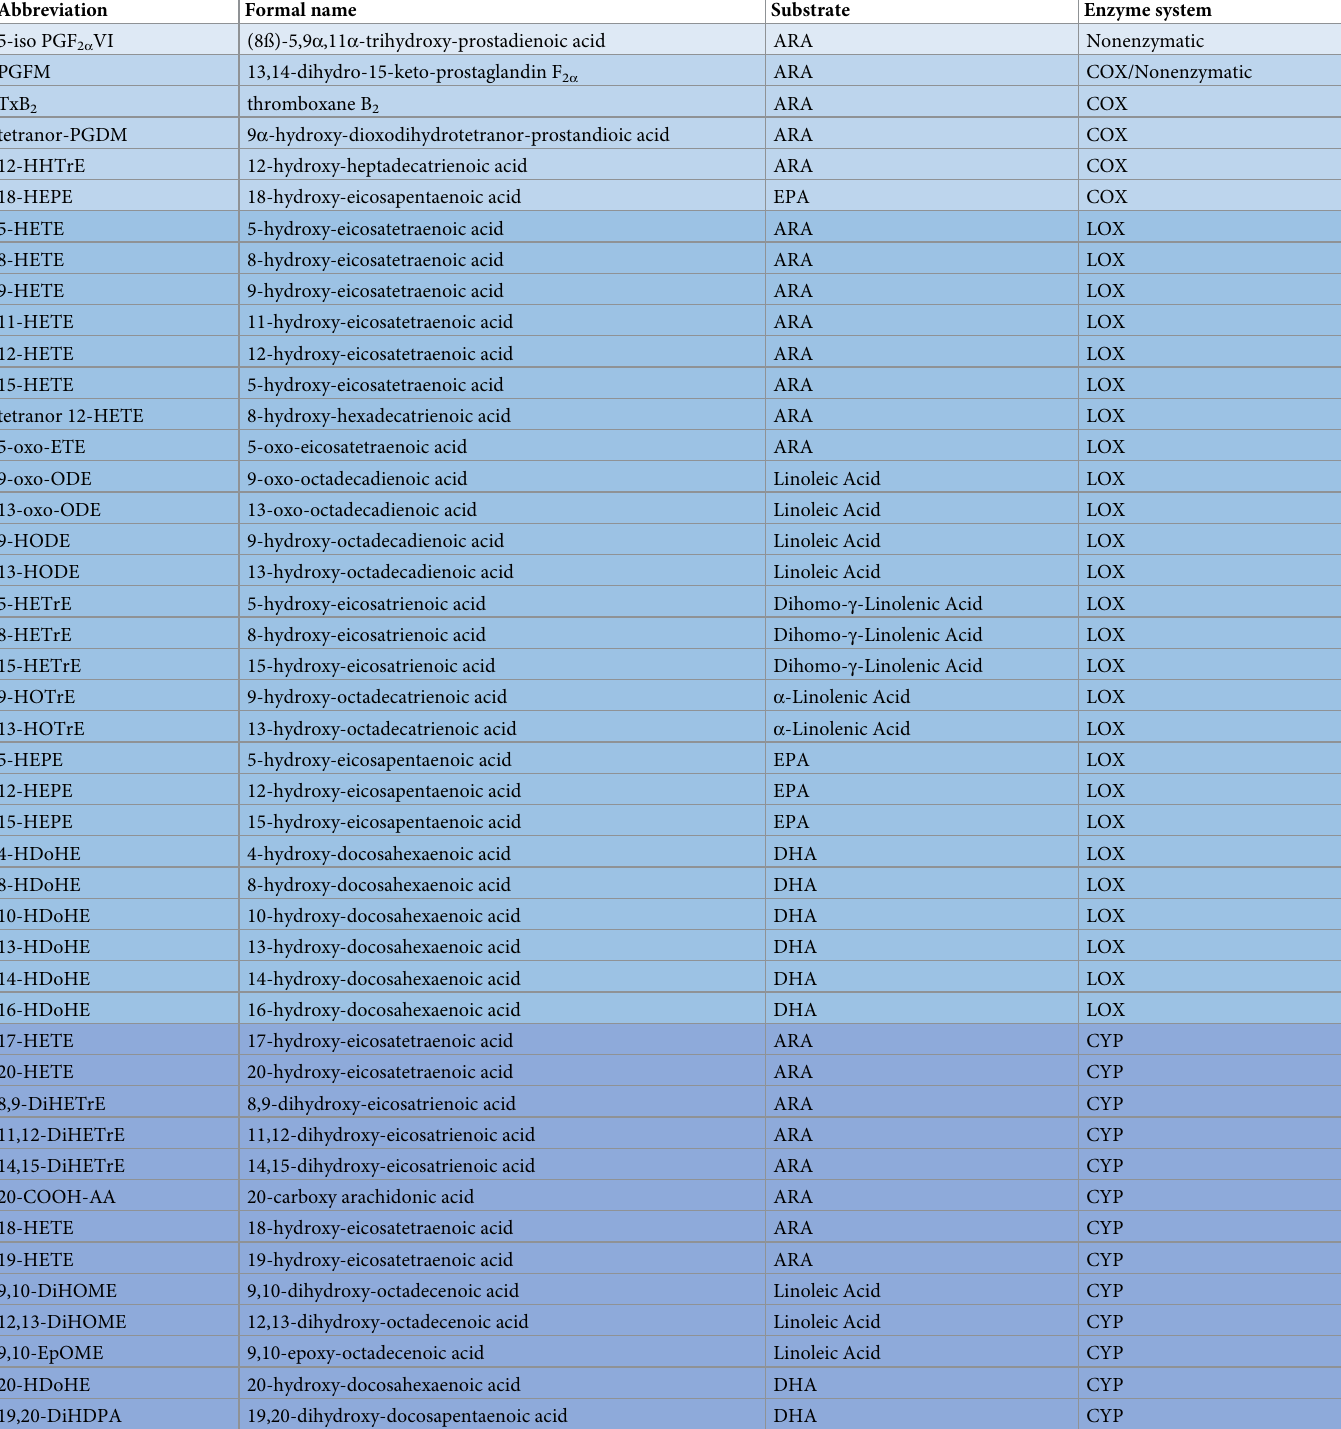
Table 1. Abbreviations, formal names, substrate sources, and enzyme systems for the 45 oxylipins detected in this analysis.